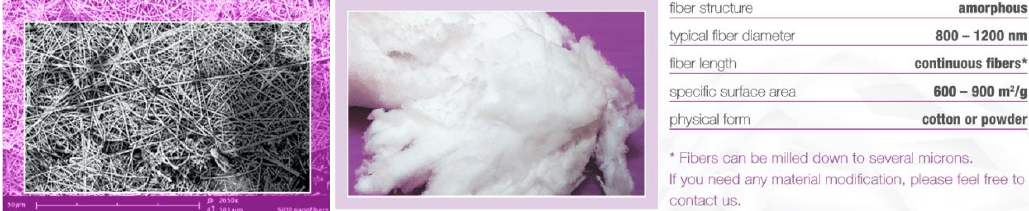
Figure 4. SEM image porous SiO 2 nanofibers, magnification 2650×, ( left ), wool from porous SiO 2 nanofibers ( middle ), and material characteristics ( right ).